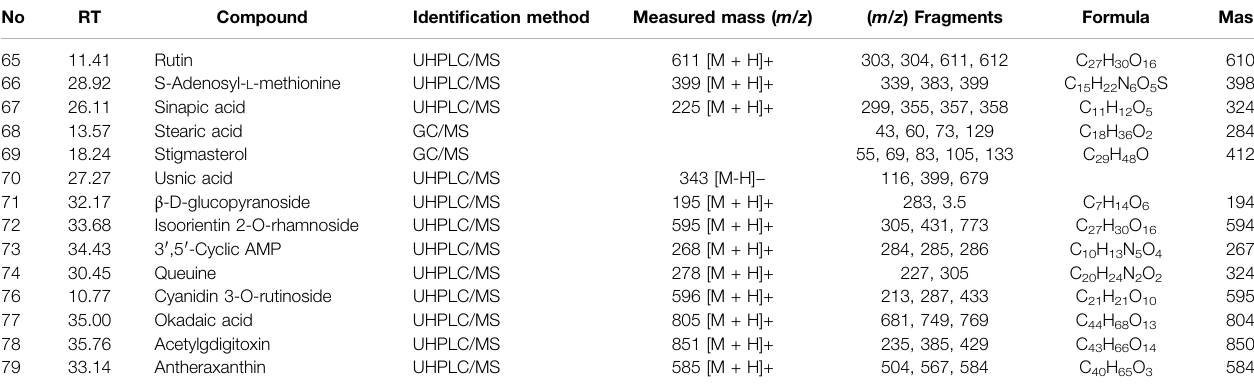
Frontiers in Pharmacology |